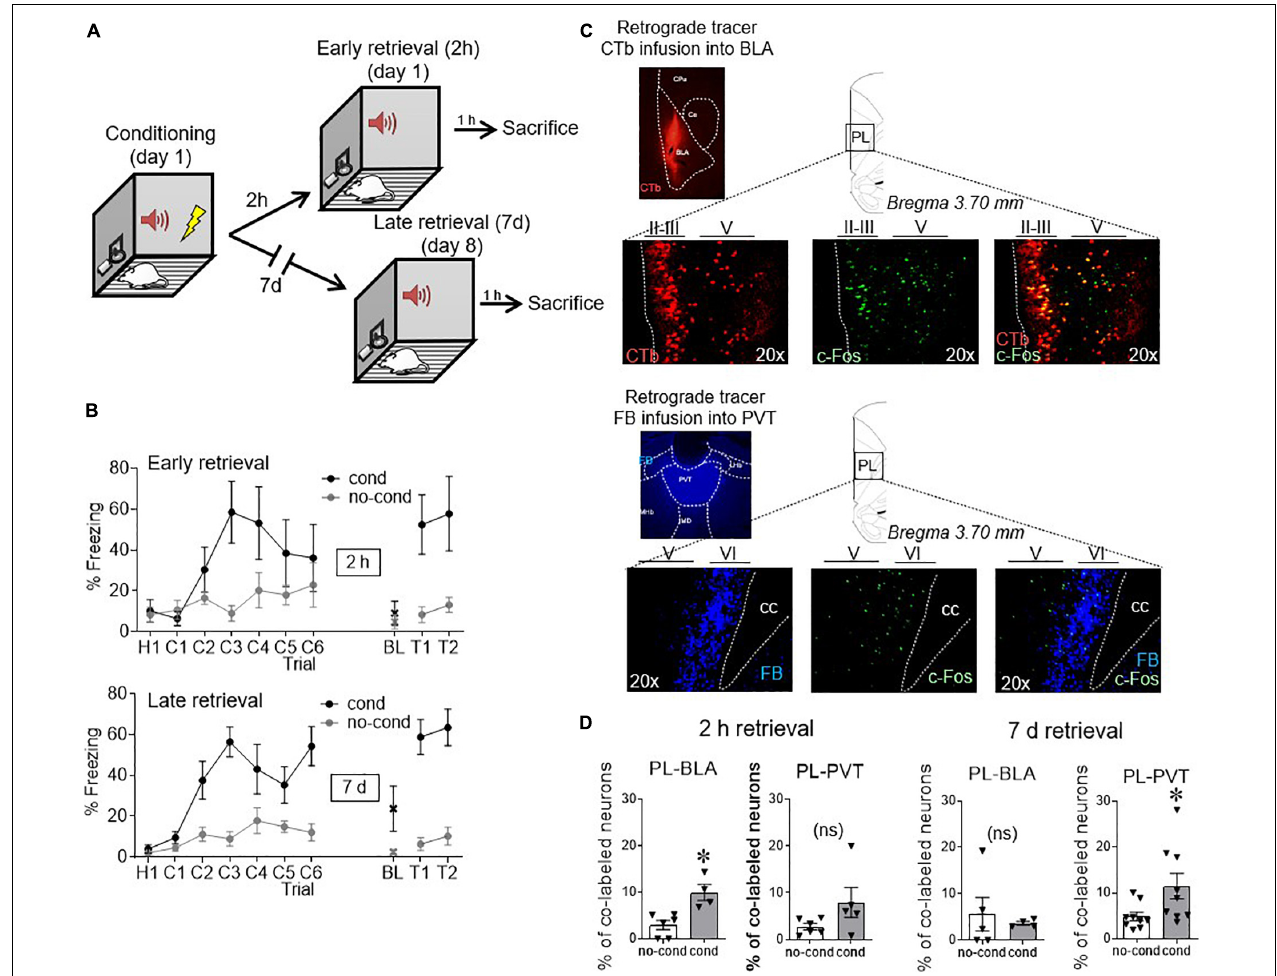
FIGURE 1 | Conditioned activity in PL neurons shifts with time, from BLA-projecting to PVT-projecting neurons. (A) After retrograde tracer infusions, rats received fear conditioned followed by retrieval tests either 2 h or 7 days later. (B) Freezing levels during conditioning and early retrieval (top) and late retrieval (bottom) . (C) Example micrographs of retrograde tracers infused into BLA and PVT and their respective staining in PL neurons, together with c-Fos staining (performed at 2 h in BLA and 7 days in PVT). (D) Group data of co-labeling of tracers with c-Fos in PL. PL-BLA neurons showed significant activation during the 2 h (but not 7 days) retrieval test, whereas PL-PVT neurons showed significant activation during the 7 days (but not 2 h) retrieval test. ∗ p < 0.05. n = 6 rats per group. Error bars depict mean and SEM in this and subsequent figures. ns = not